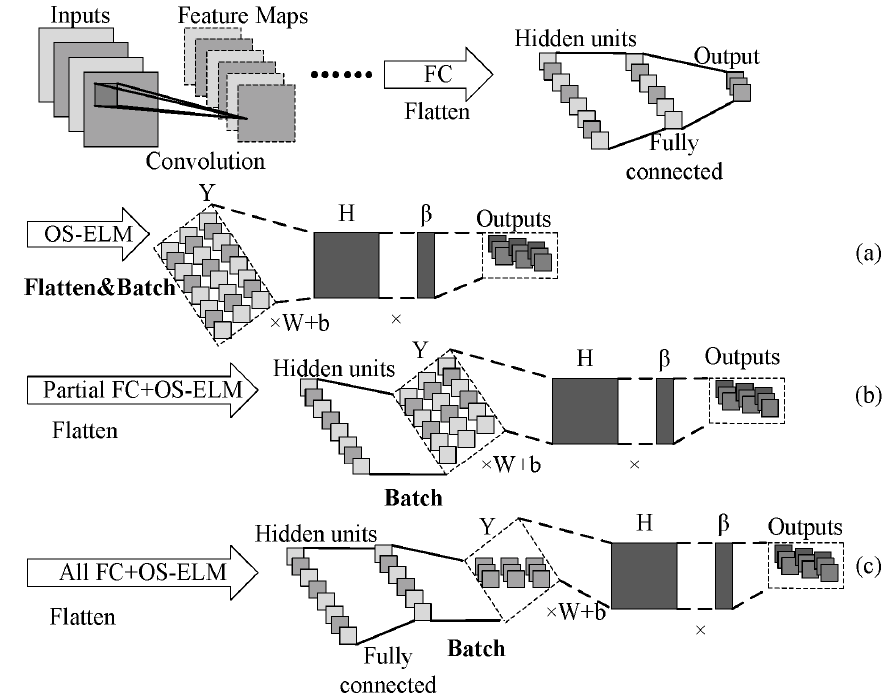
Figure 1. Network structures of a traditional neural network and fnnmOS-ELM (online sequential extreme learning machine) models. ( a ) The OS-ELM is used as a classifier in the original network. ( b ) The OS-ELM replaces part of the network layers of the classifier in the original network. ( c ) The fnnmOS-ELM is used as the optimiser of the original network.